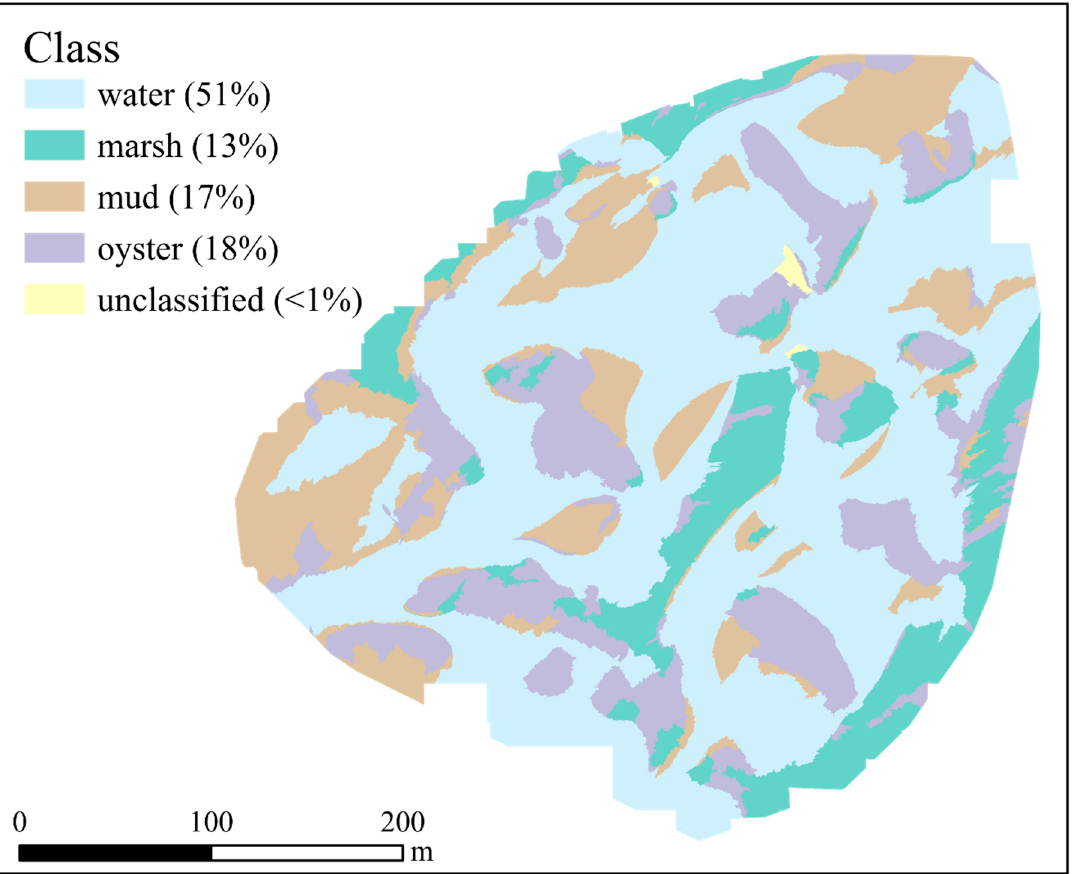
Figure 7. Habitat map produced from the standard nearest neighbor classification.